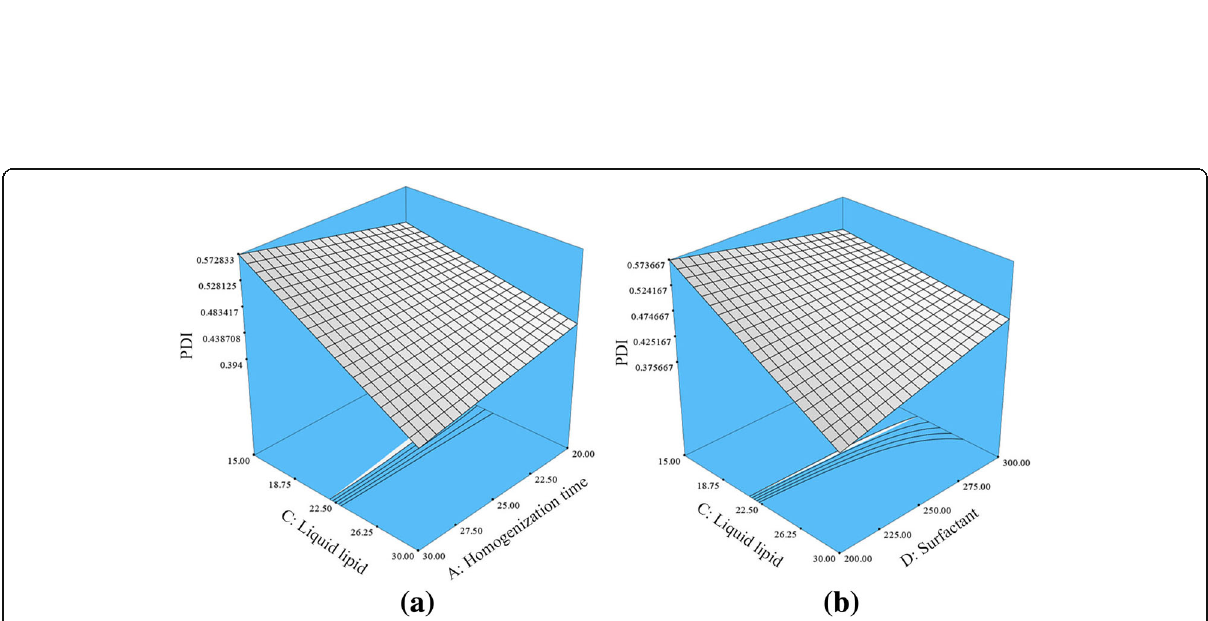
Fig. 3 Response surface plot depicting the significant ( p < 0.05) effect of liquid lipid concentration and interactions between a AC and b CD on PDI of HVD-NLCs. A homogenization time, C liquid lipid, D surfactant